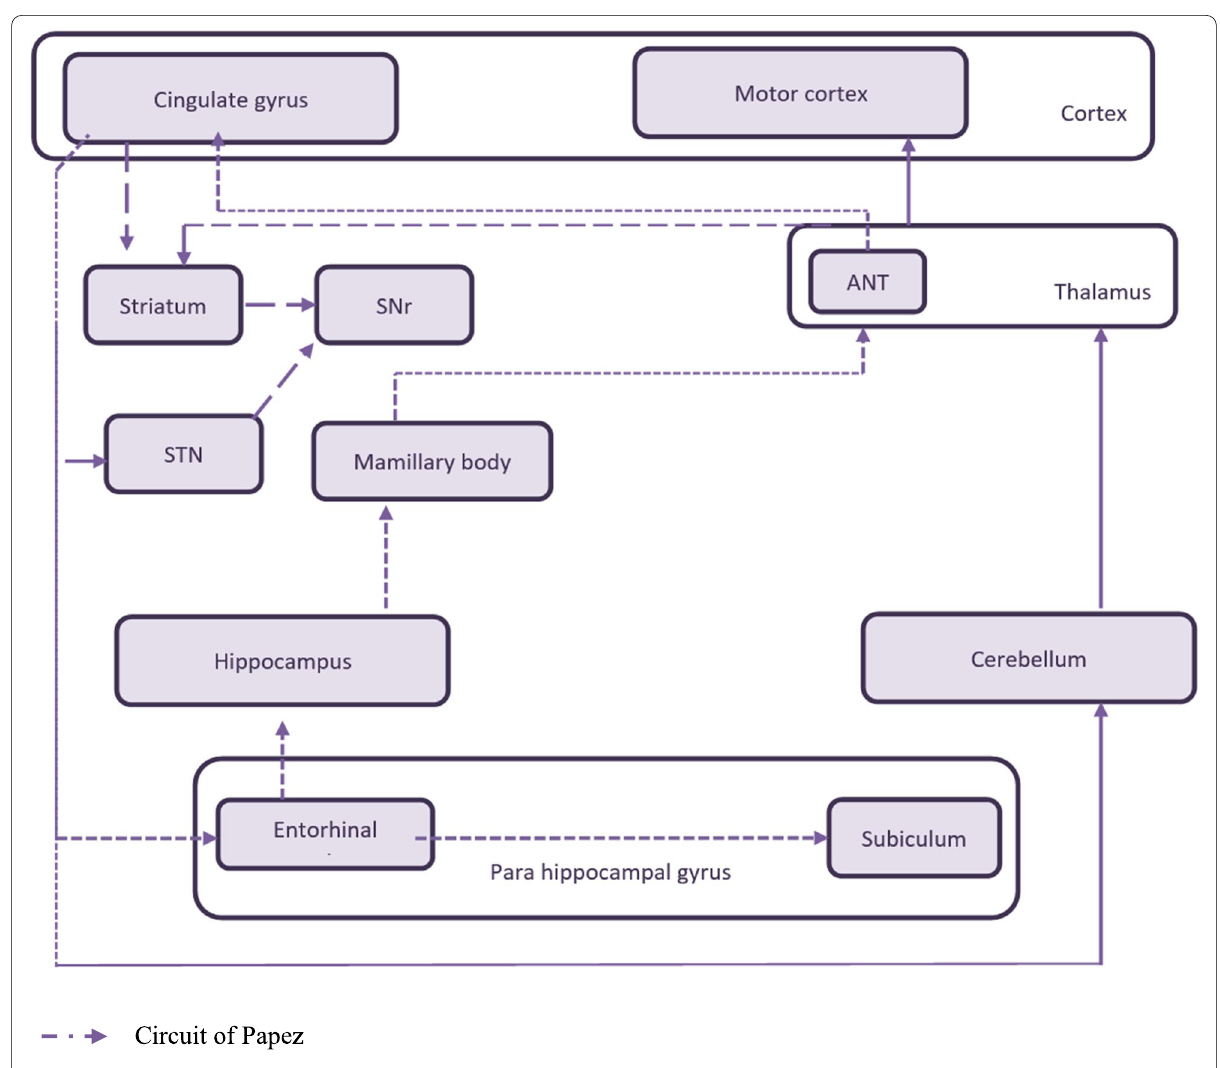
Fig. 1 Anatomical targets for neurostimulation and associated neural circuitry. SNr, substantia nigra pars reticularis; ANT, anterior thalamic nucleus; STN, sub thalamic